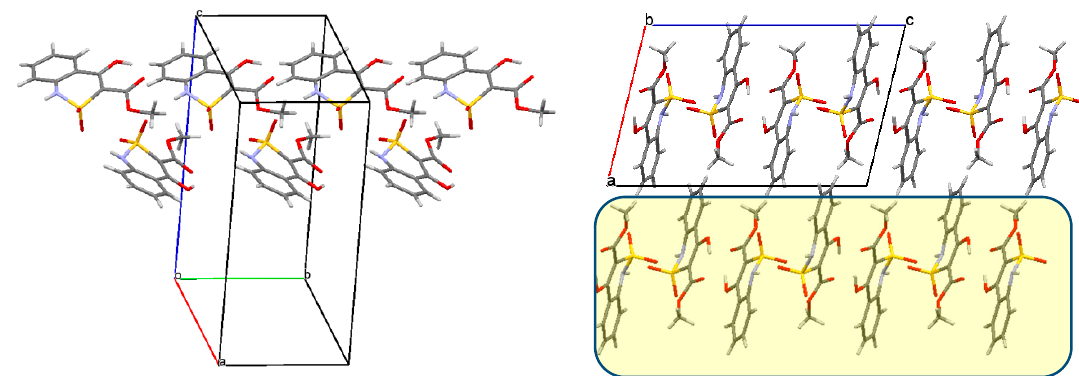
Figure 4. ( Left ) a chain of the molecules of ester 4a along the crystallographic direction [0 1 0]; ( right ) packing of the molecules of ester 4a , projection along the crystallographic direction [0 1 0], the layers parallel to the crystallographic plane (0 1 1) are marked in yellow.